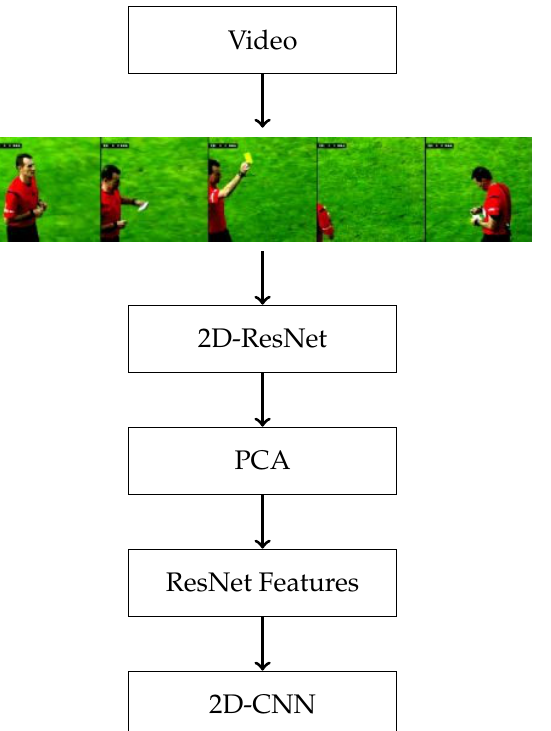
Figure 3. Illustration of the pipeline used by the video-based 2D-CNN model. A pre-trained ResNet is used to extract features from video, followed by PCA [1]. The features can then be used to train a network for action detection